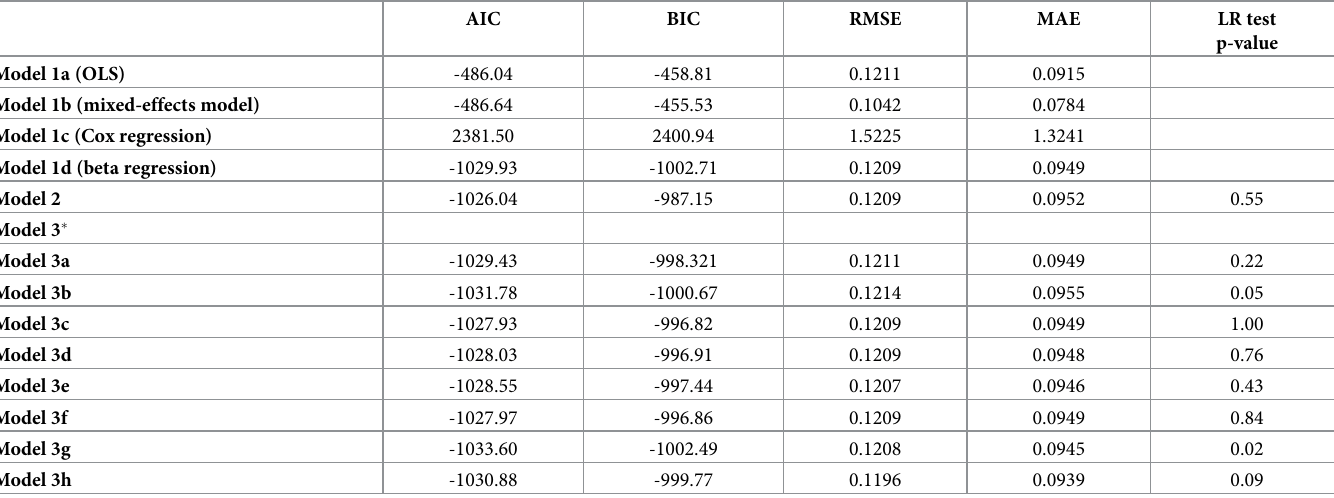
Table 3. Summary results of the regression models.